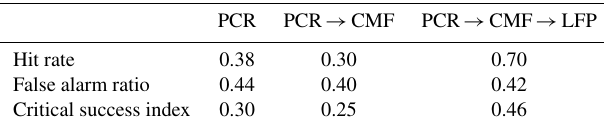
Table 3. Hit rate, false alarm ratio, and critical success index for the three model